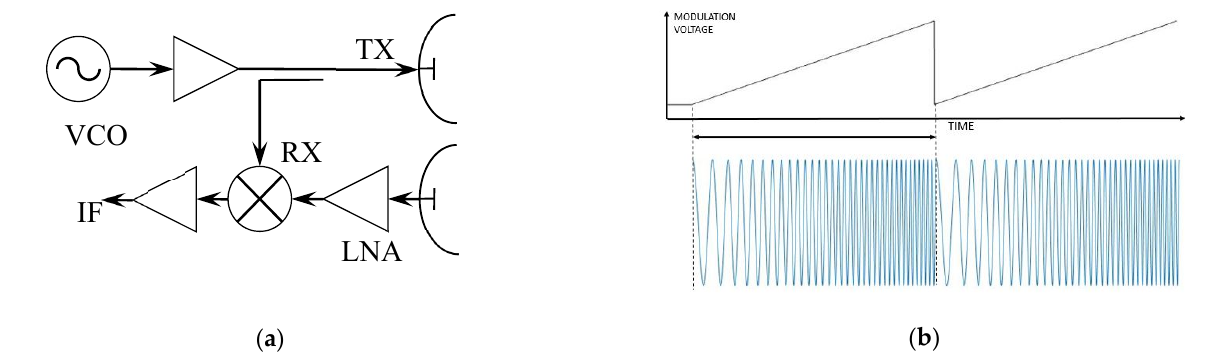
Figure 1. ( a ) FMCW radar block diagram and ( b ) example waveforms.